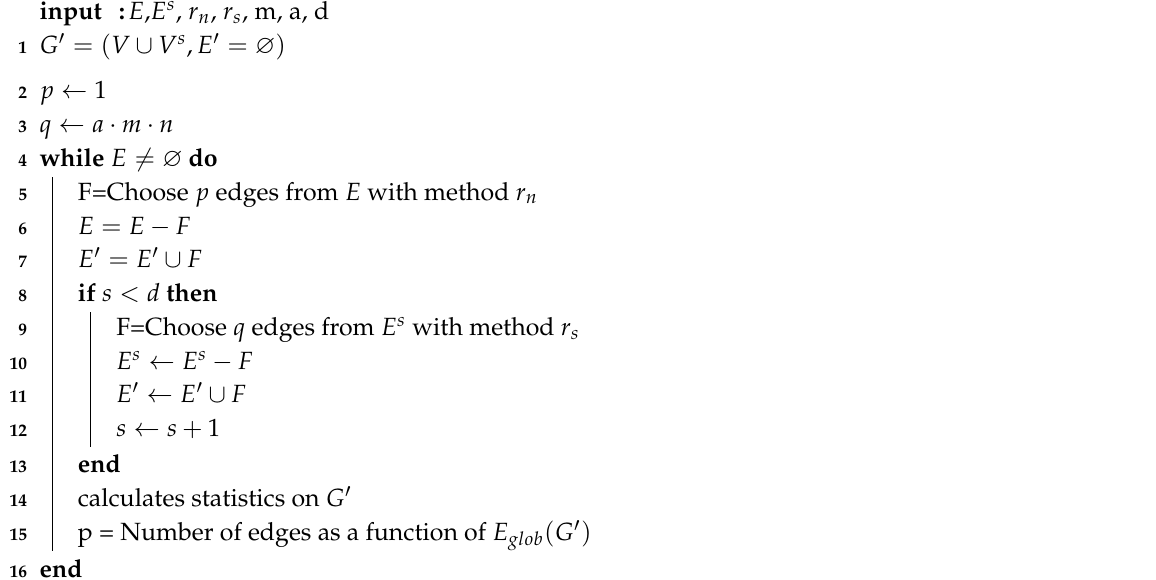
Algorithm 2: Accelerated networks simulation with